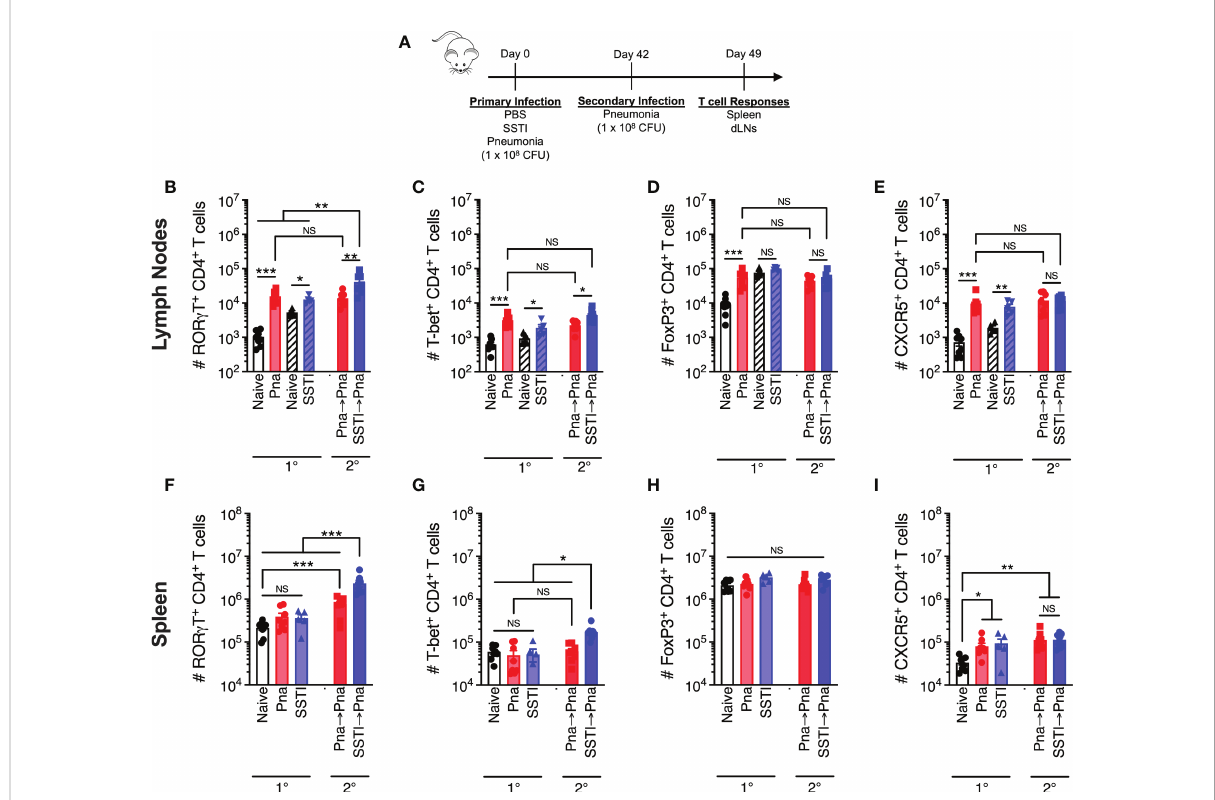
FIGURE 3 Local and systemic T cell responses against S. aureus pneumonia and SSTI. CD4 + T cell populations were quanti fi ed 7 days following primary SSTI or pneumonia (Pna) or secondary pneumonia following SSTI (SSTI ! pna) or pneumonia (pna ! pna) [model in (A) ] in the draining lymph nodes (dLNs), (B – E) or the spleen (F – I) . (B – E) There were increased numbers of ROR g t + , T-bet + , FoxP3 + , and CXCR5 + CD4 + T cells in the mediastinal dLNs (open bars) following pneumonia, compared with naïve mice, and increased numbers of ROR g t + , T-bet + , and CXCR5 + CD4 + T cells in the inguinal dLNs (hatched bars) following SSTI. Primary SSTI primed greater expansion of ROR g t + and T-bet + CD4 + T cells in the mediastinal dLNs following secondary pneumonia, compared with those primed by primary pneumonia. (F – I) There was no increase in ROR g t + , T-bet + , or FoxP3 + CD4 + T cell populations in the spleen following pneumonia or SSTI, but there were increased numbers of CXCR5 + CD4 + T cells following pneumonia and SSTI, compared with naïve mice. Primary SSTI primed greater expansion of ROR g t + and T-bet + CD4 + T cells in the spleen following secondary pneumonia, compared with those primed by primary pneumonia. N=5-8 mice group pooled from 2 independent experiments; all data are presented as mean ± SEM. Data were compared using one-way ANOVA on log 10 -transformed values